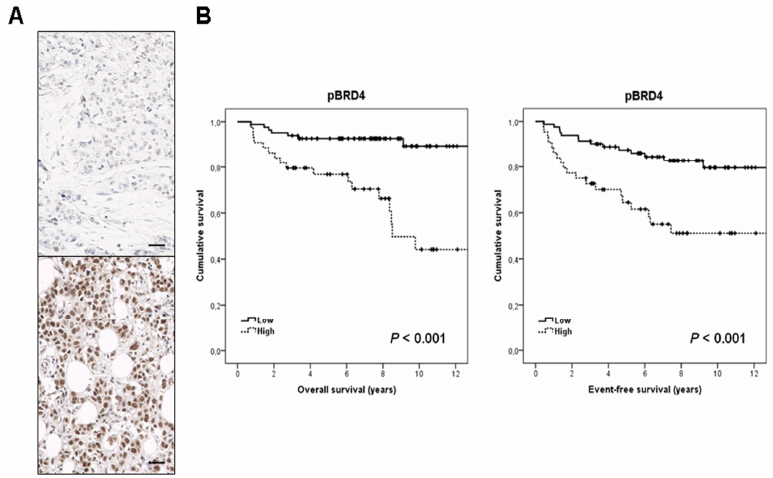
Figure 1. Clinical significance of pBRD4 in TNBC. ( A ) Immunohistochemical images showing pBRD4 positive and negative staining. The line shows 25 μm. Original magnification ×400, ( B ) Kaplan–Meieranalysesof overall survival(OS) and event-free survival(EFS) in a cohort of 132 TNBC patients.